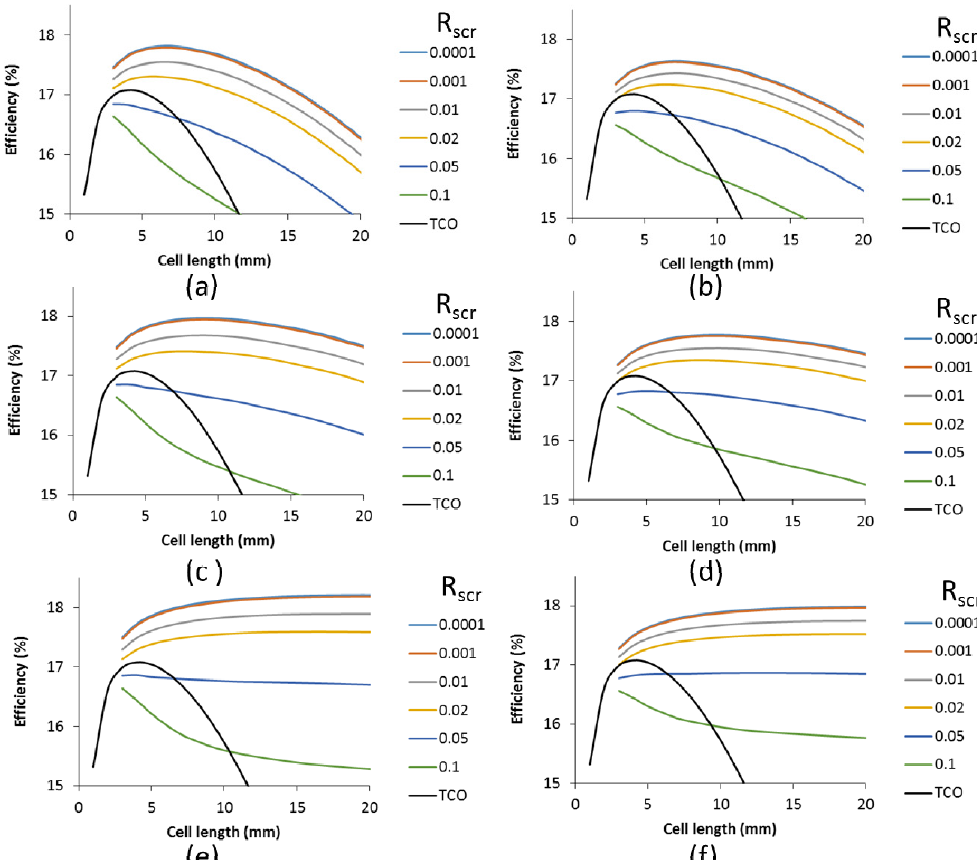
Figure 11. Efficiency as a function of the cell length for various specific contact resistances (see legend, R scr , in Ω cm 2 ), and TCO (without contact resistance) for cells with finger grid width of 20 μ m ( a , c , e ) and 60 μ m ( b , d , f ) and a height of 2 μ m ( a , b ), 5 μ m ( c , d ) and 50 μ m ( e , f ). Calculations were based on a 19% small cell.